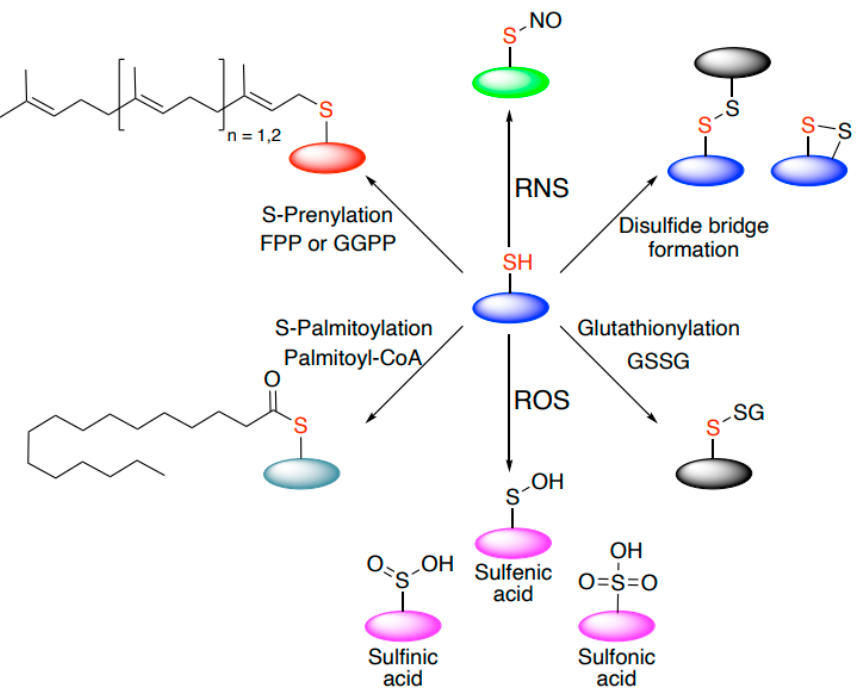
Figure 1. Thiol-based cysteine modifications. Cysteines may undergo a wide range of thiol-based chemical modifications. These include both reversible (e.g., sulfenic acid, disulfide bridge formation, palmitoylation) and irreversible modifica- tions (e.g., sulfinic acid, sulfonic acid,